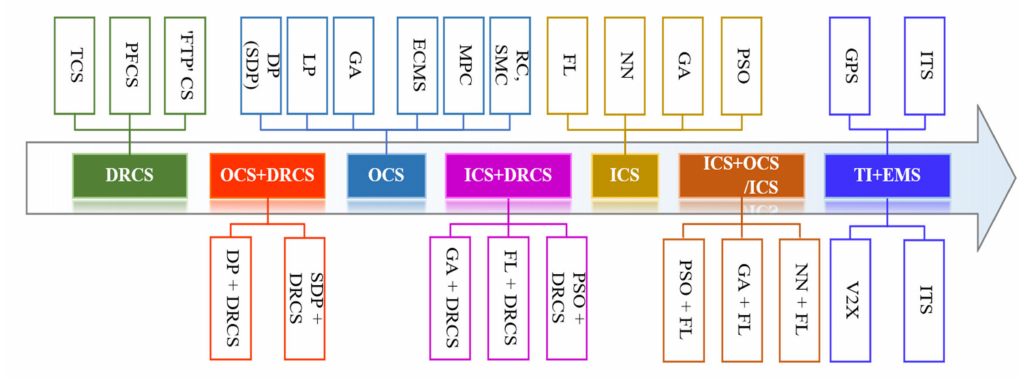
Figure 22. Classification based on development and